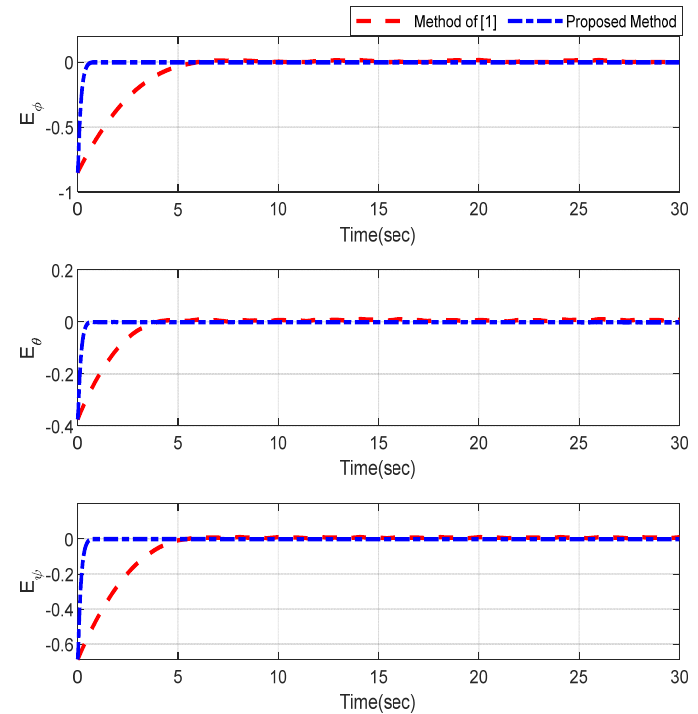
Figure 5. Trajectories of attitude tracking errors .